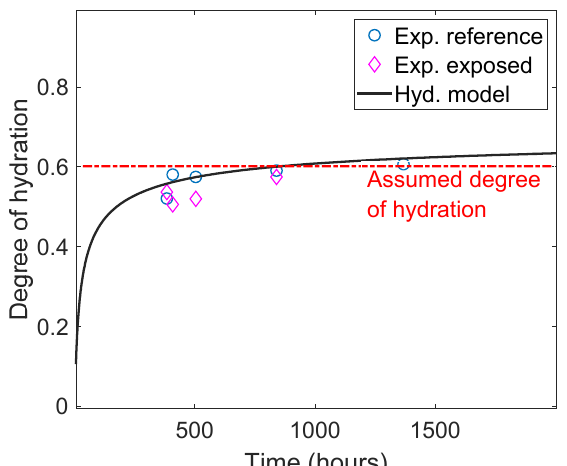
Figure 2. Comparison of experimental results and hydration model to estimate the degree of hydra- tion from TGA measurements using the method proposed in [49]. Note that exposure started after 15 days of curing; hence, the first datum was around 380 h.